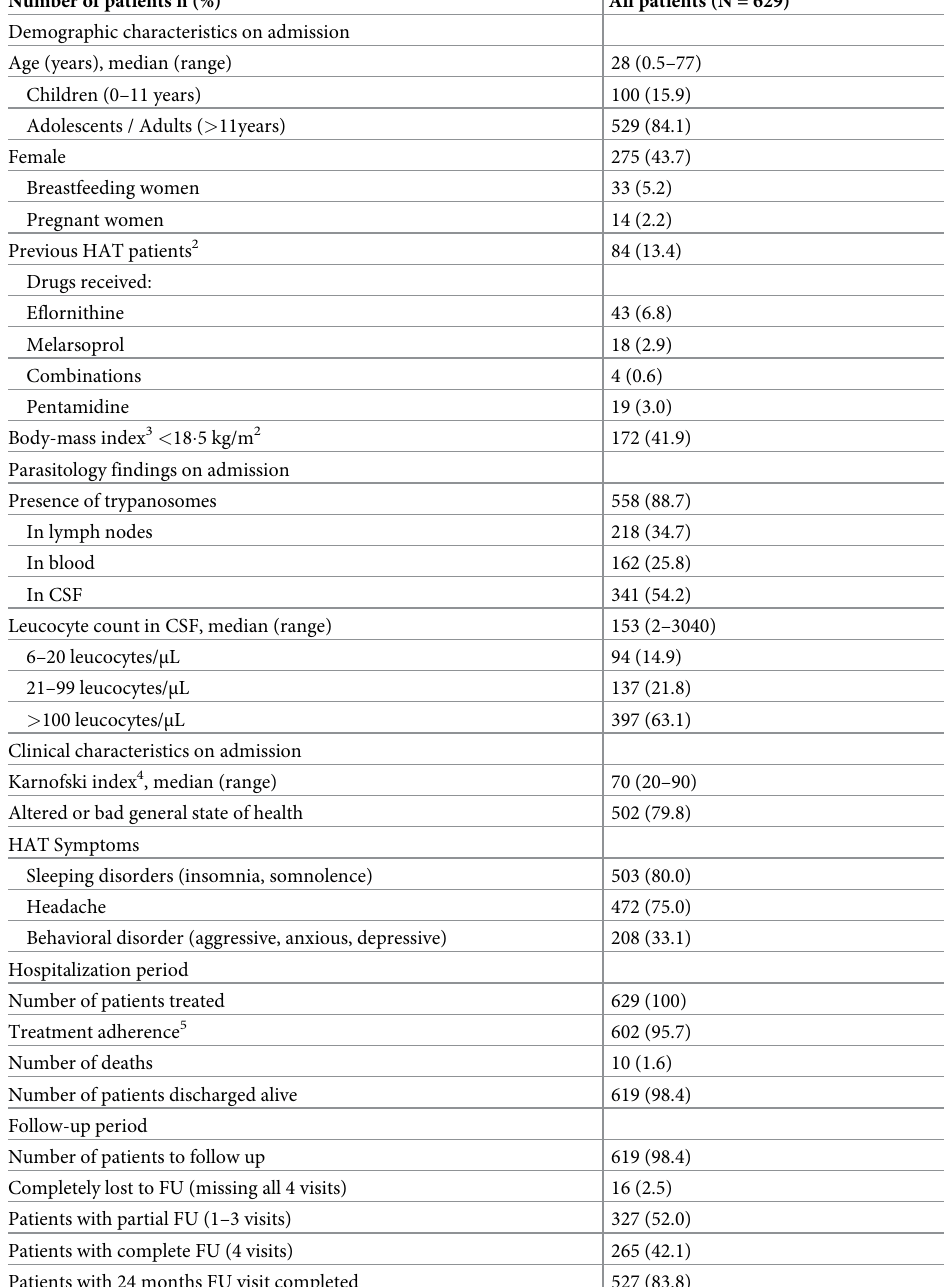
Table 1. Patient characteristics on admission, and during treatment and